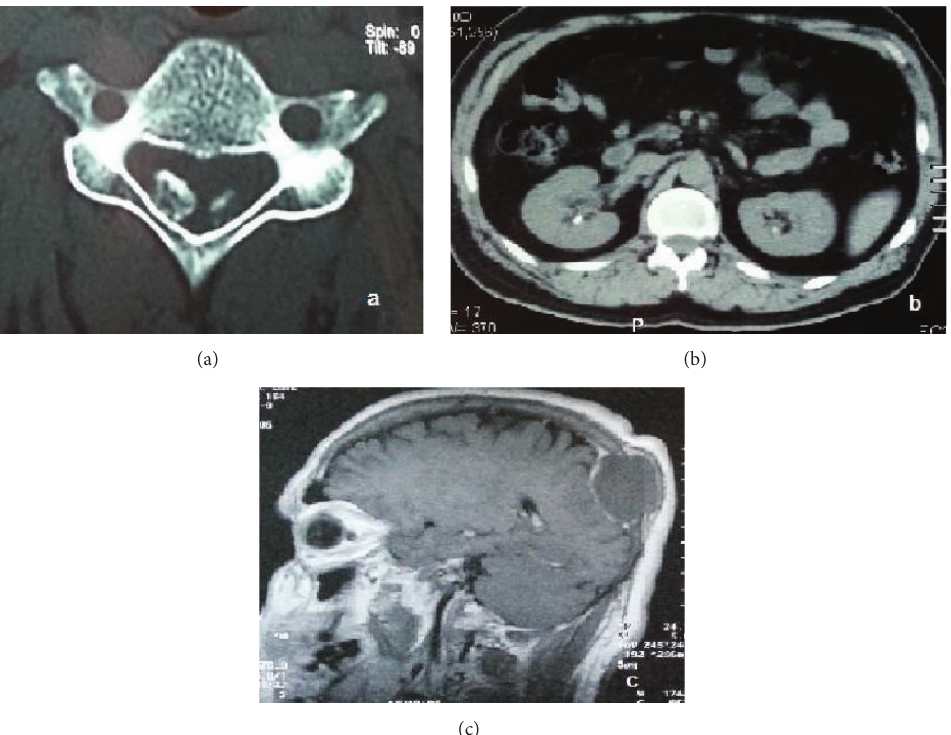
Figure 1: A 45-year-old man with parathyroid carcinoma: (a) ossification of the cervical ligamentum flavum in C2-C3 and C4-C5 without signs of myelopathy. (b) Nephrolithiasis in both kidneys and (c) left parietal bone tumor (5.5 × 3.2 × 4.4 cm) from Magnetic Resonance Imaging scan.